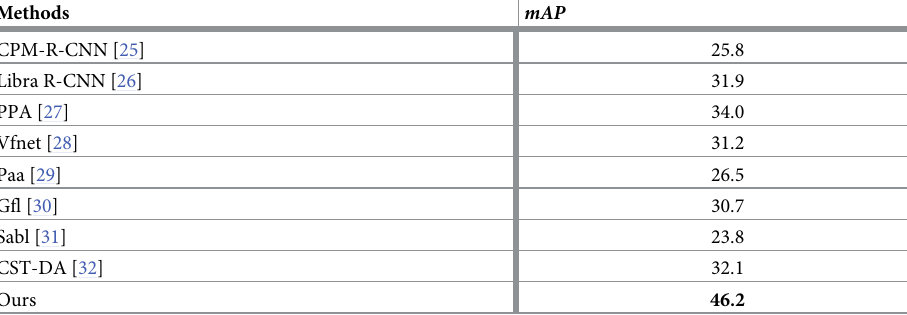
Table 1. Experimental results of different methods on “Cityscape to Foggy” data set.